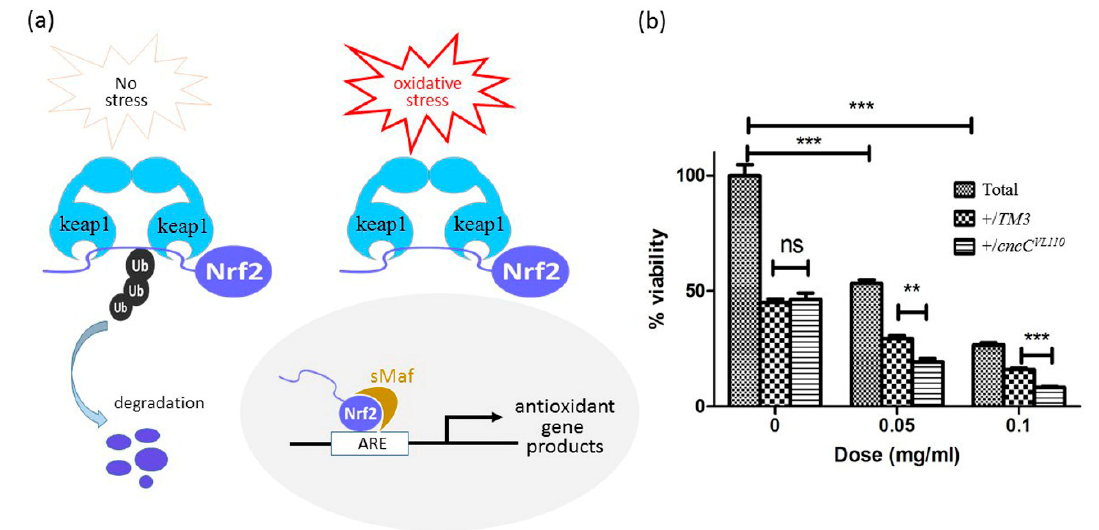
Figure 6. ROS levels modulate the toxic effects caused by CuONPs. ( a ) Schematic diagram suggesting the role of Nrf2 in the regulation of antioxidant gene expression; ( b ) Introducing one mutant allele of CncC (the Drosophila homolog of Nrf2) further decreased the poor survivorship caused by CuONP exposure. Error bar = SEM, ** p -value < 0.01; *** p -value < 0.001.